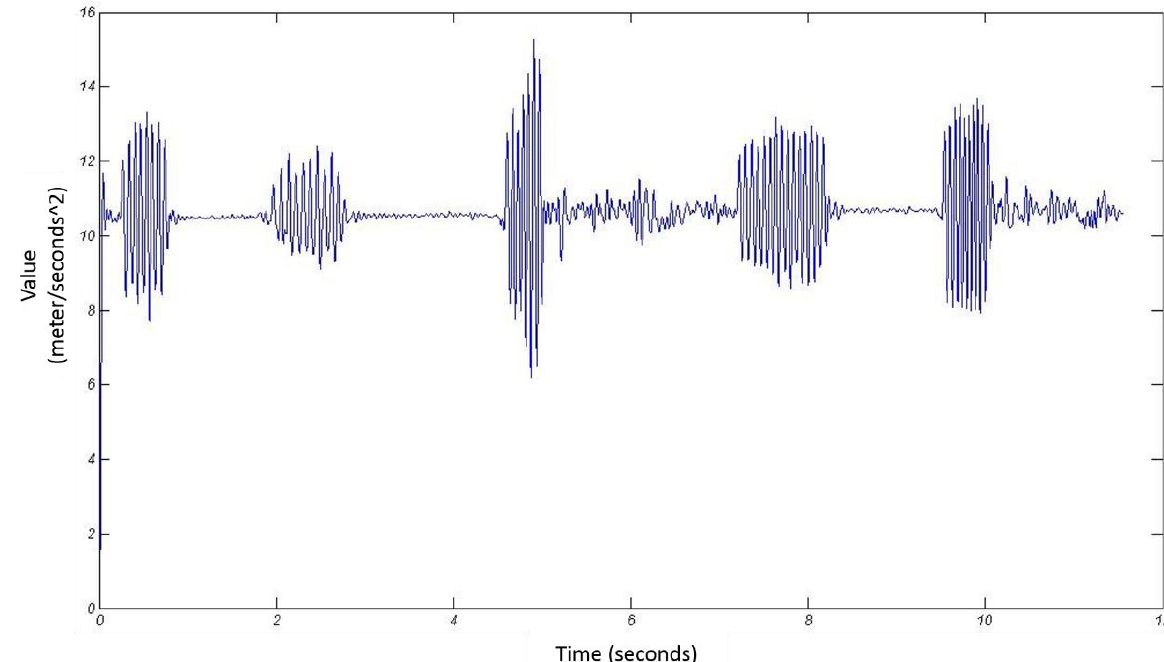
Figure 3. Three axes of the smart phone (Loulier, 2011) Considering the huge amount of bothering noise, a low-pass filter was used to suppress it. Having studied low-pass filters, butterworth low-pass filter was chosen among many others such as Chebyshev filter, elliptic filter, Bessel Filter, Gaussian filter, Linkwitz-Rilet filter, etc.